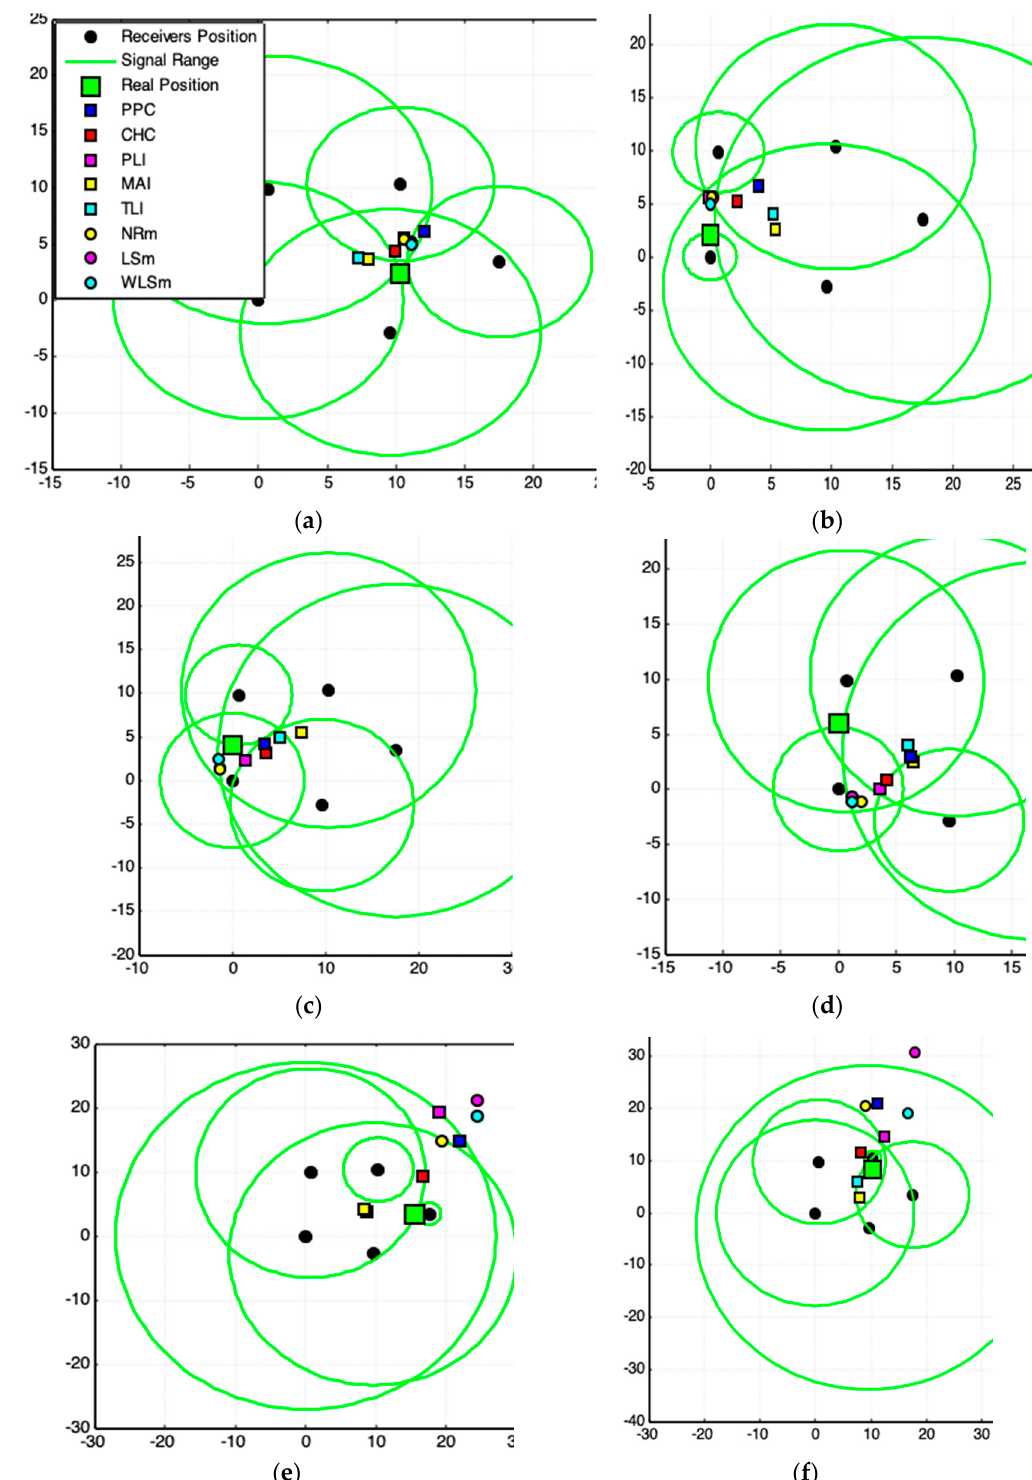
Figure A1. Complementary experimental results.